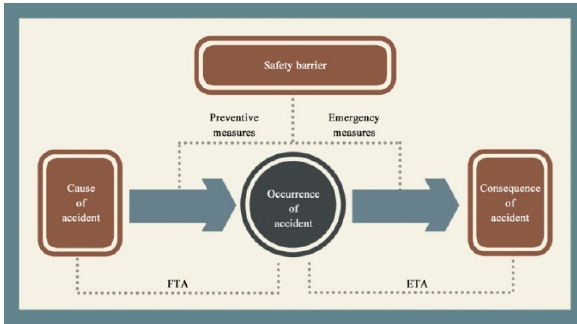
Figure 2. Bow-tie model of pipeline failure accidents.